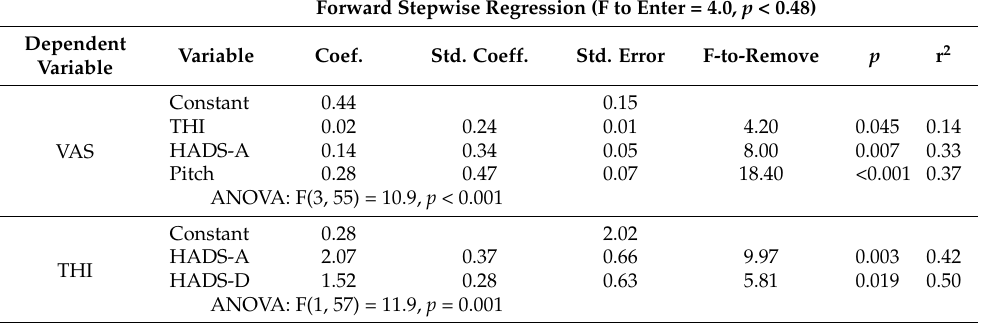
Table 6. Results of forward stepwise regression analysis to identify predictors of post-treatment changes in VAS or THI